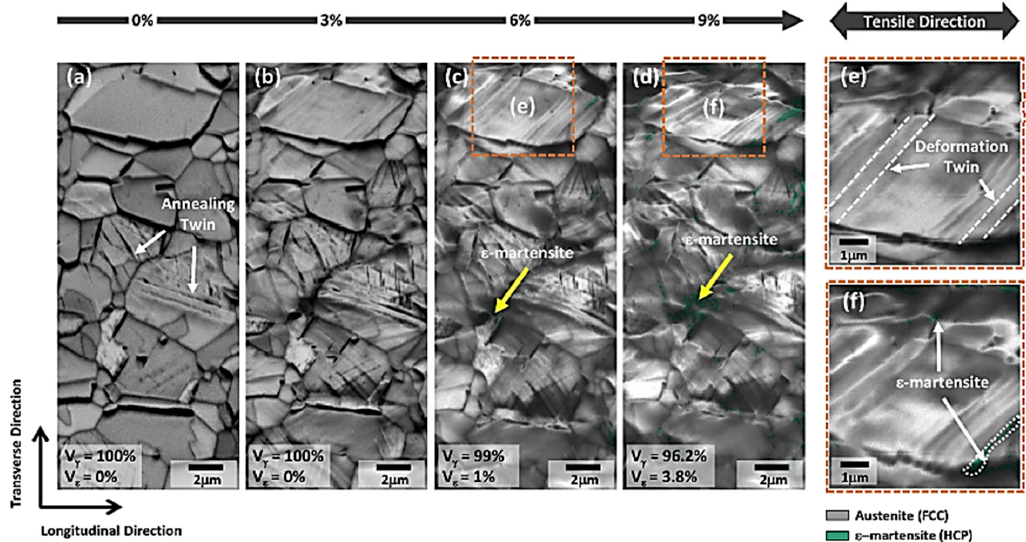
Figure 5. Microstructural evolution of 1 wt% Cu-added steel at the early deformation stage: electron backscatter diffraction IQ maps with phase identification of the areas deformed after the interrupted tensile test at engineering strains of ( a ) 0%, ( b ) 3%, ( c ) 6%, and ( d – f ) 9% for the 1wt% Cu steel. At the strain of 6%, the ε -martensite starts to form and grow. ( e , f ) High-magnification maps of the dashed boxes in ( c , d ), respectively. Sub-microstructures composed of parallel lines, i.e., deformation twins, are developed inside an austenite grain. The ε -martensite also forms at an austenite grain boundary and a deformation twin. Reprinted from [47], with permission of Elsevier, 2019.